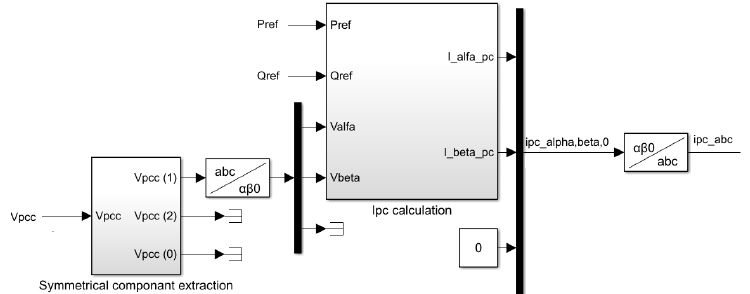
Figure 5. Reference current calculation under balanced PCC voltages.